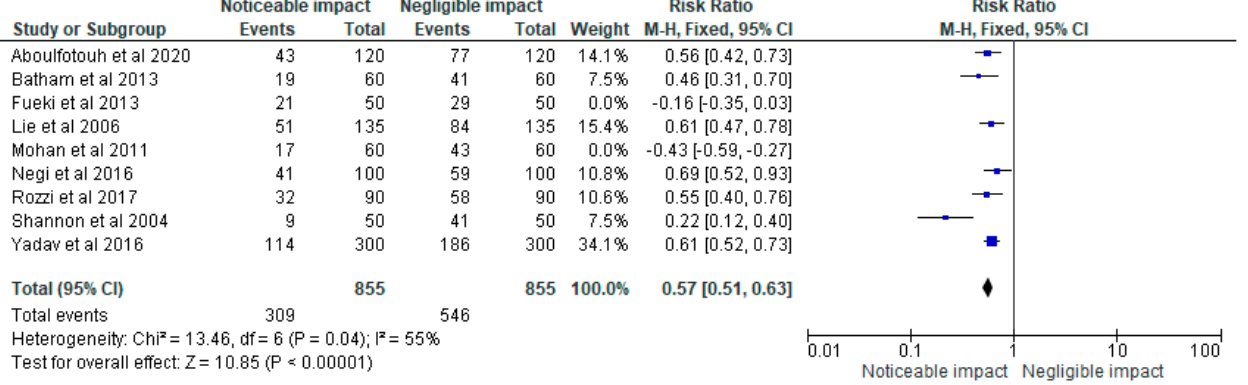
Figure 3. Forest plot of the risk ratio representing the impact status of COS accentuation on masticatory efficiency in the clinical trials [2,18–25] selected for meta-analysis (assuming a 95% confidence interval).